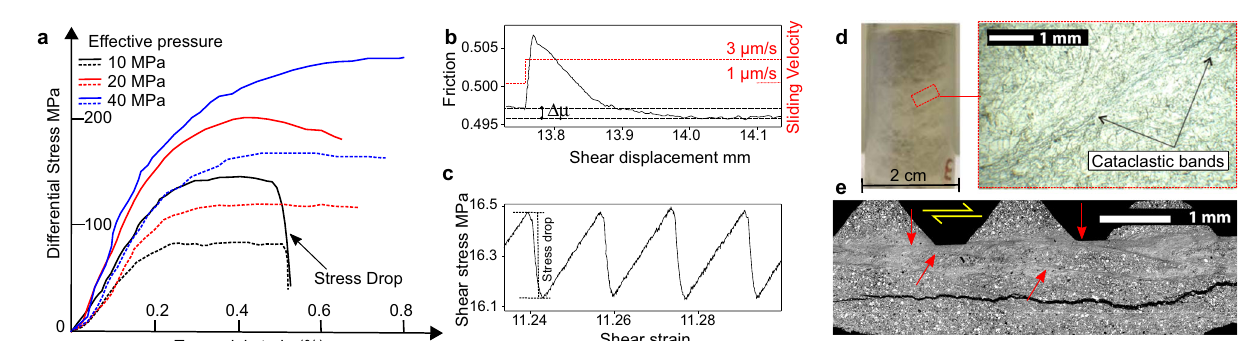
Fig.5|BrittlefaultingalongmajornormalfaultswithinTriassicEvaporites,TE. a , b Large displacement (hundreds of meters) normal faults with brittle deforma- tion,characterizedbygrain-sizereductionandlocalizationalongprincipalslipping